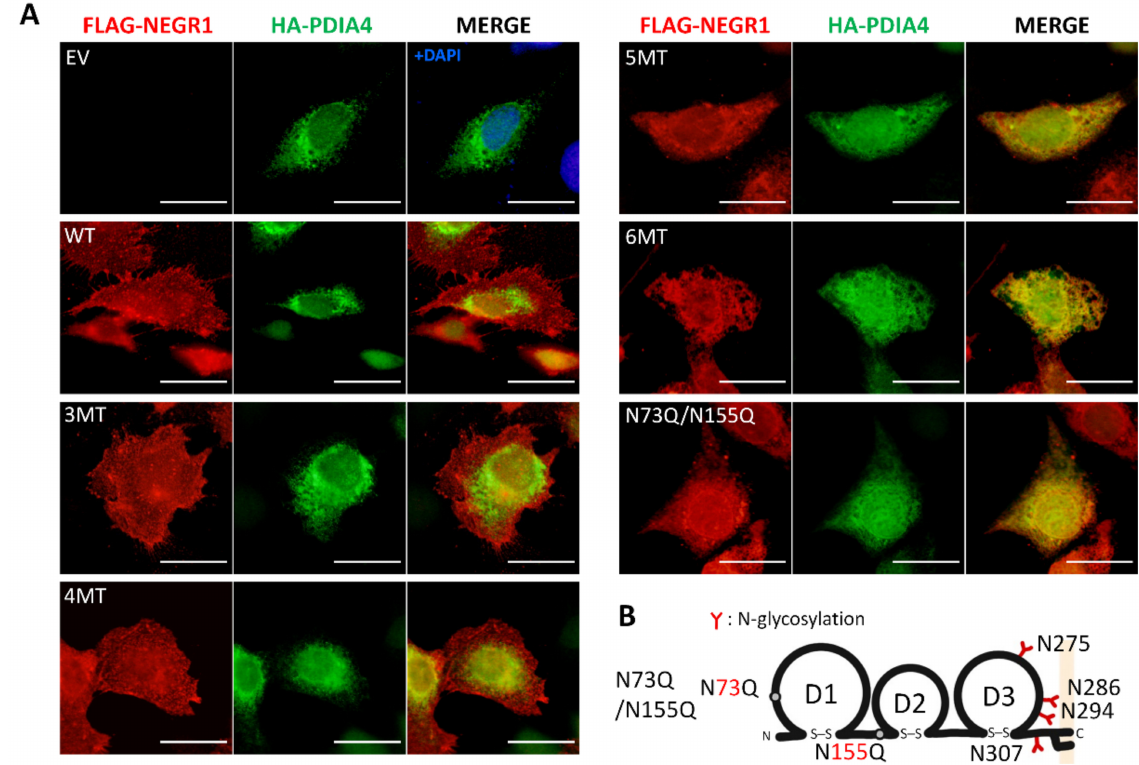
Figure 4. Subcellular localization of NEGR1 N -glycosylation mutants. ( A ) HeLa cells were co- transfected with FLAG-NEGR1 mutant constructs and HA-PDIA4 for 24 h. Then, cells were double- immunostained with anti-FLAG and anti-HA antibodies, followed by Cy3 anti-rabbit and fluorescein isothiocyanate anti-mouse secondary antibodies. Images were captured using the Olympus BX51 fluorescence microscope. Scale bar = 50 µ m. ( B ) Schematic representation of the N73Q/N155Q